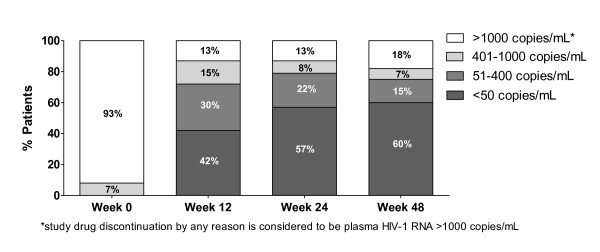
Percentage of patients who had different stratum of plasma HIV-1 RNA at weeks 48 of treatment by intend-to-treat analysis.